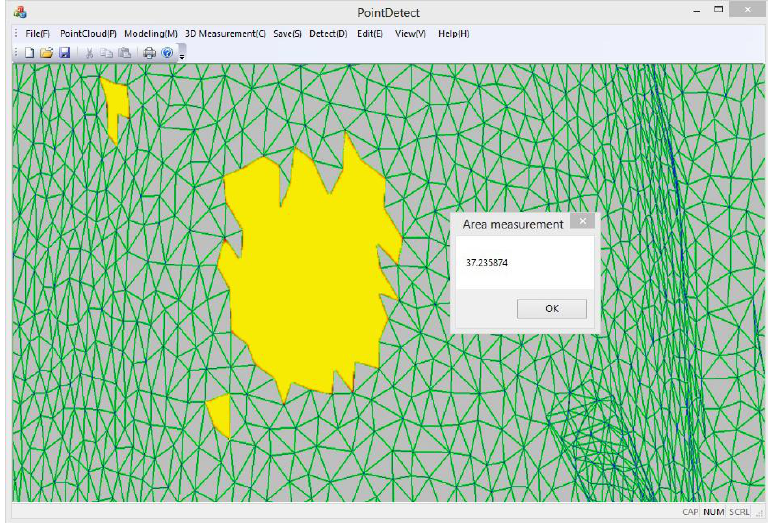
Figure 20. A damaged region calculation (the yellow region is the damaged region).